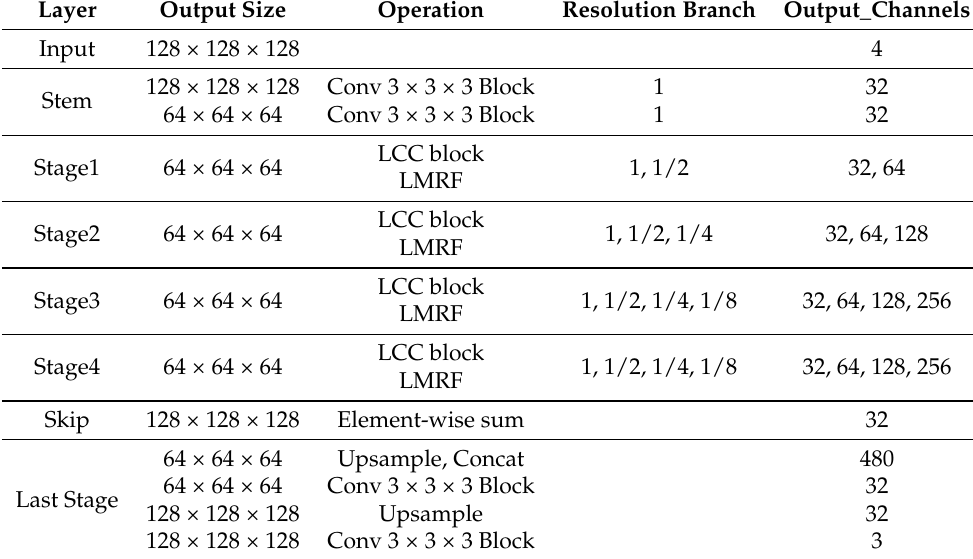
Table 1. The network structure of HMNet, where Conv 3 × 3 × 3 Block stands for 3 × 3 × 3 convolution, and Group Normalization, ReLU, and Concat stand for channel-wise